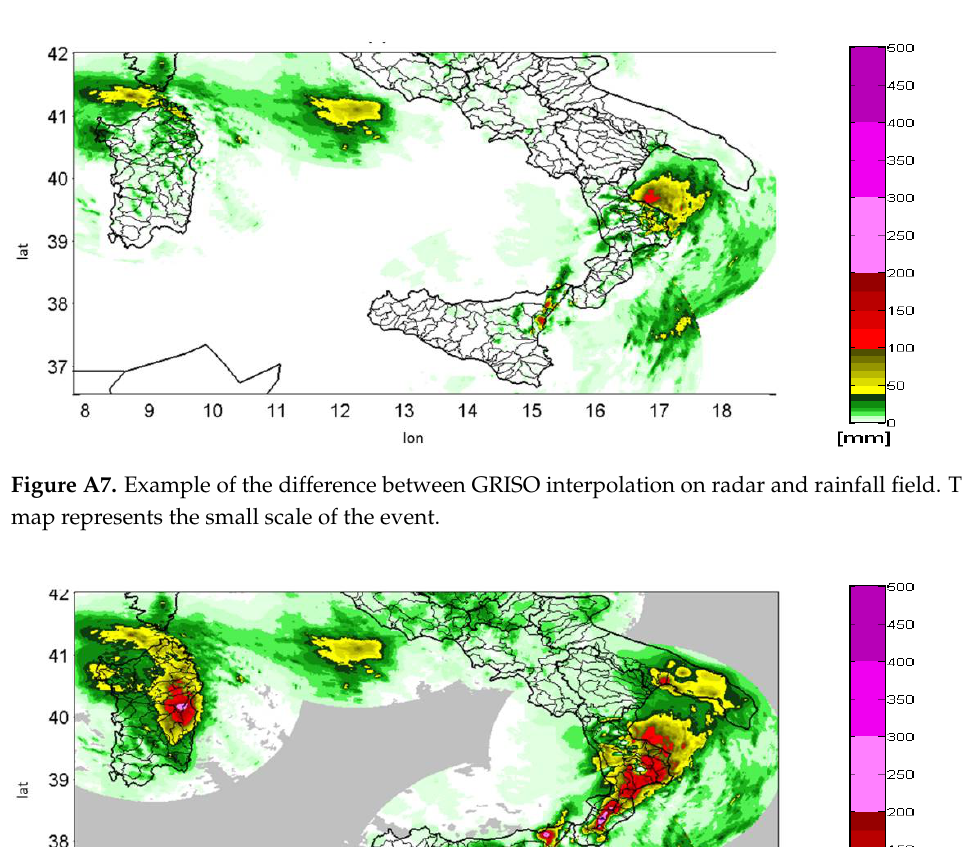
Figure A6. Example of GRISO interpolation of radar values sampled on rain gauge locations.